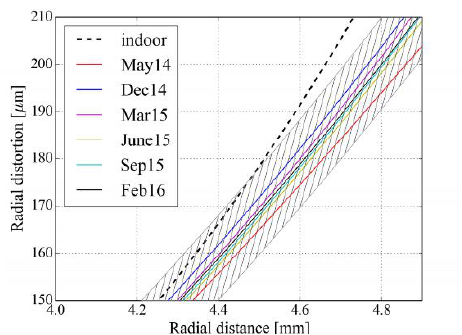
Figure 4. Detail of the radial distortion curves at the outer corner of the